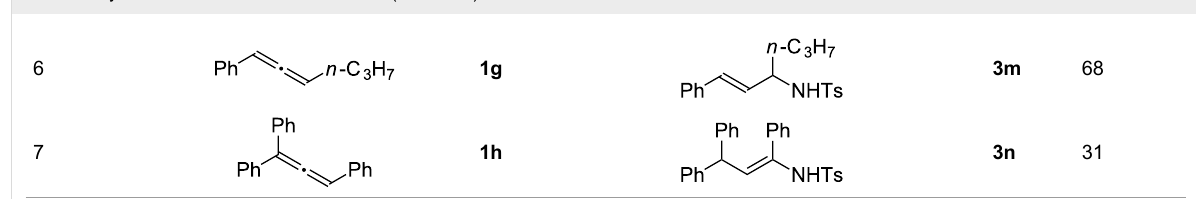
Table 3: Hydroamination of allenes 1 with 2a . a (continued)